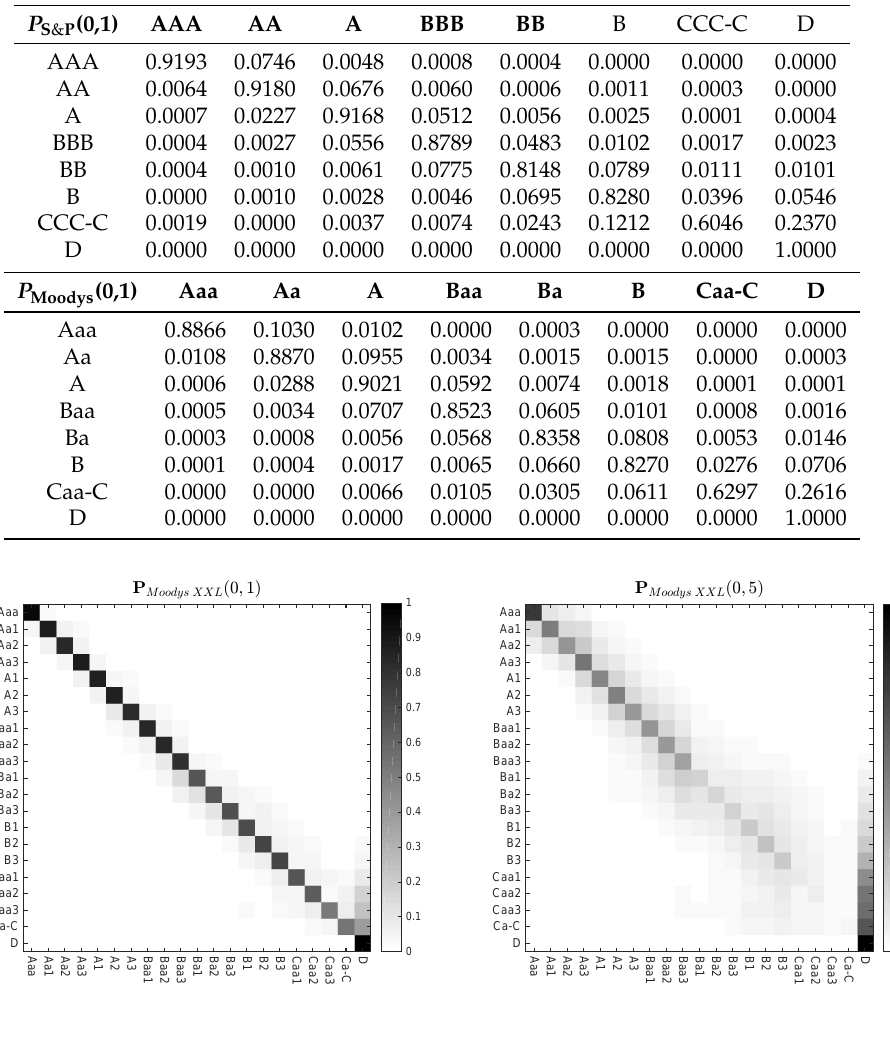
Table A1. The 8 × 8 matrices P S&P ( 0,1 ) and P Moodys ( 0,1 ) are adopted from the paper of [14], whereas a visual depiction of the 21 × 21 matrices P Moodys XXL ( 0,1 ) (companies without ratings (WR) are simply = p ij removed by computing p WR for i , j = 1, . . . , K ) and P Moodys XXL ( 0,5 ) is given (both matrices ij 1 − p i , WR can be found in [28]).